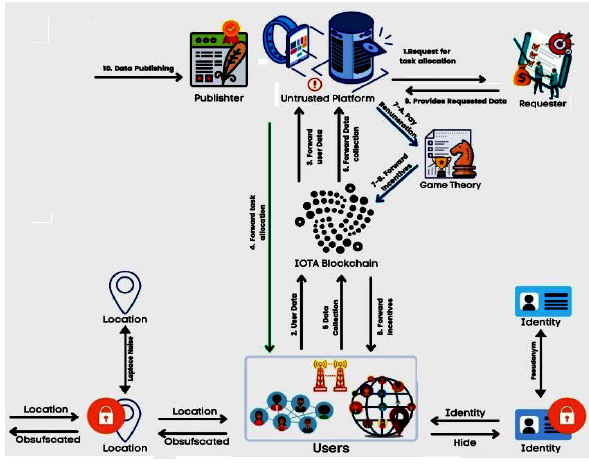
Figure 1. IOTA Block chain Methods